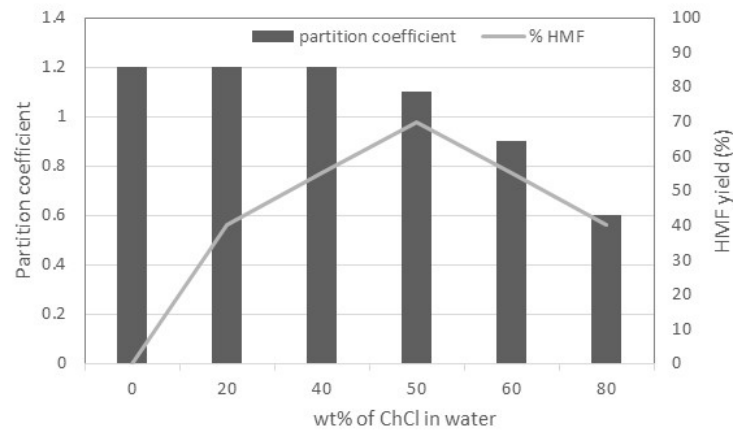
Figure 1. Effect of the wt % of ChCl on the partition coefficient and HMF yield in a H 2 O/MIBK (methylisobutylketone) mixture.